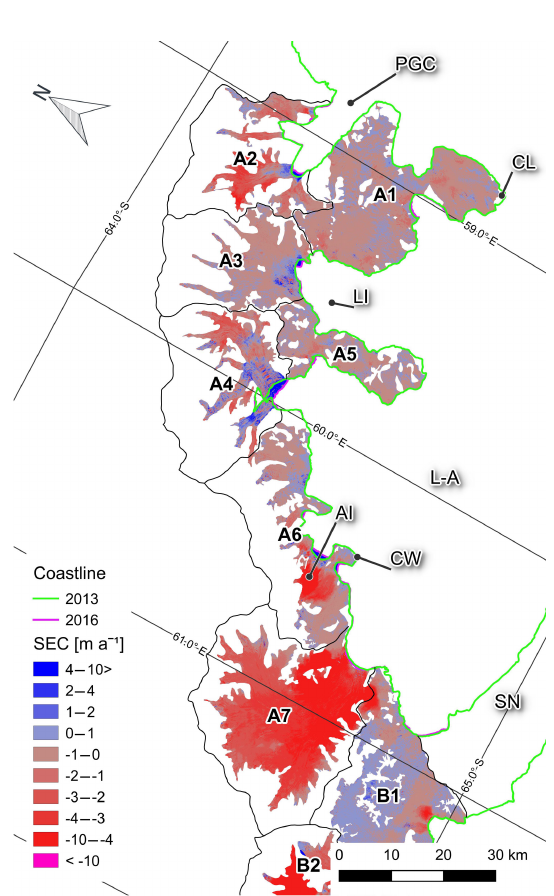
Figure 2. Map of surface elevation change d h/ d t (SEC) (ma − 1